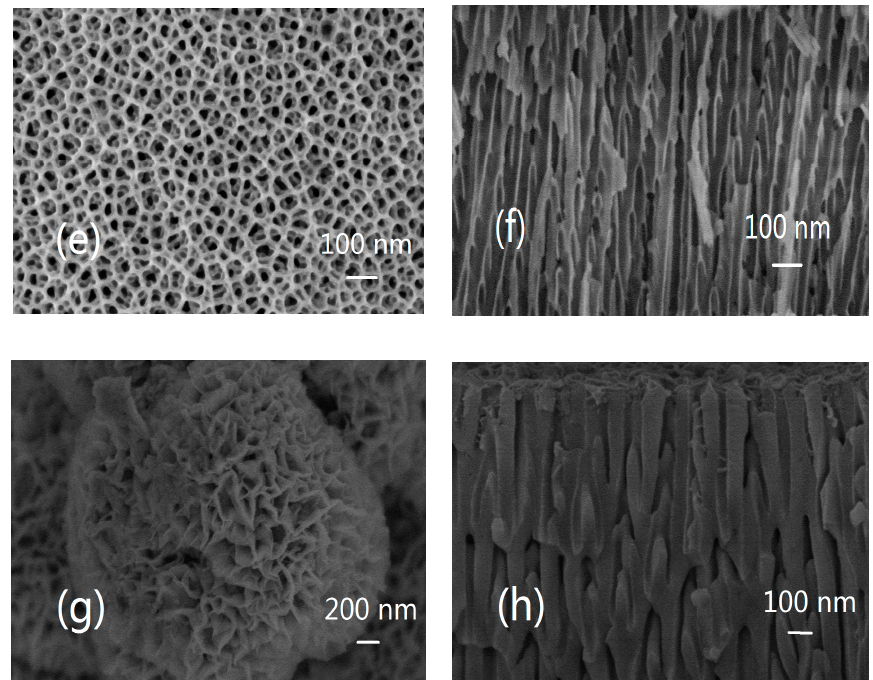
Figure 1. SEM images of the top view and the side view of the traditional alumina film ( a , b ) and Ni deposited on traditional straight pass alumina film ( c , d ); the ceramic structure alumina film ( e , f ) and Ni deposited on the ceramic structure alumina film ( g , h ) by the electrodeposition method.